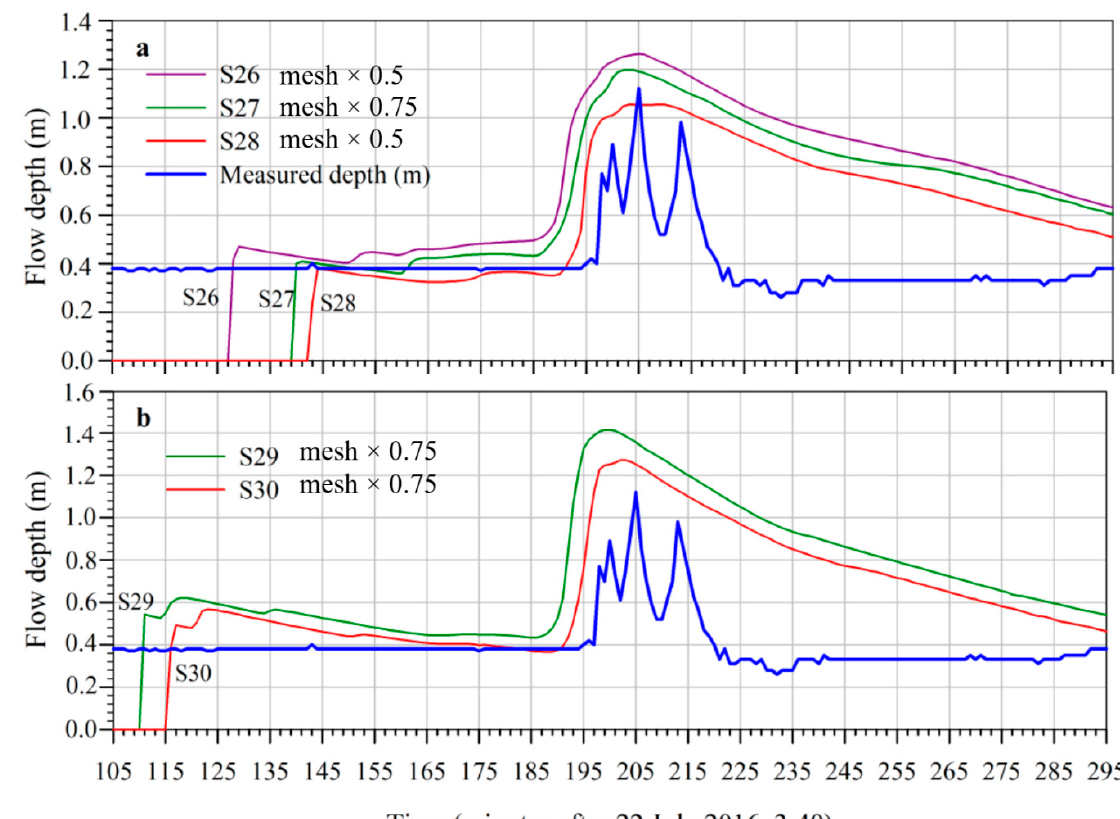
Figure 7. Simulations S26–S30 based on the Manning’s value n equal to 0.15; ( a ) S26–S27–S28 exploring the sensitivity of the CTY modelling outcomes to grid-cell width and infiltration parameters values; ( b ) S29–S30 exploring the sensitivity of the Turb modelling outcomes to only infiltration parameters values.